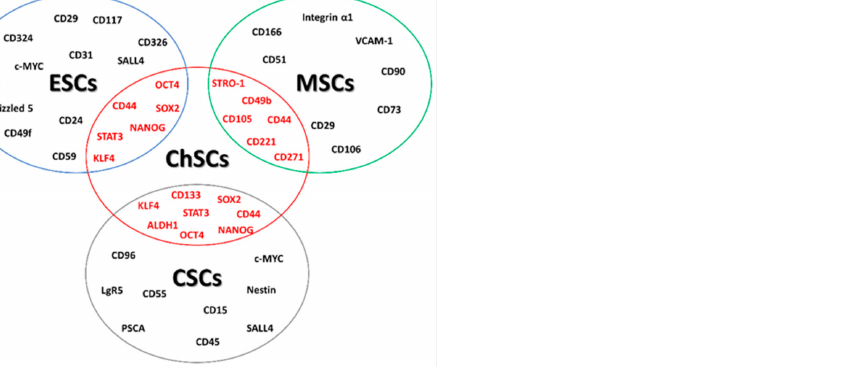
Figure 1. Chondrosarcoma stem cell (ChSC) markers. ChSC markers overlap with embryonic stem cells (ESCs), mesenchymal stem cells (MSCs), and cancer stem cells